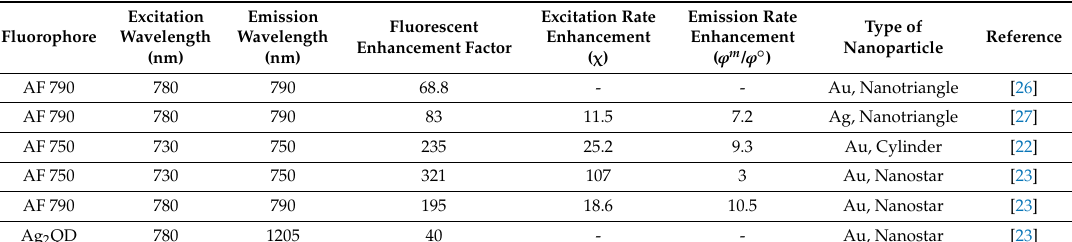
Table 1. Metal enhanced fluorescence in the near infra-red using gold (Au) and silver (Ag) nanoparticles. The excitation and emission rate enhancements are found from lifetime measurements and are not available in every case.